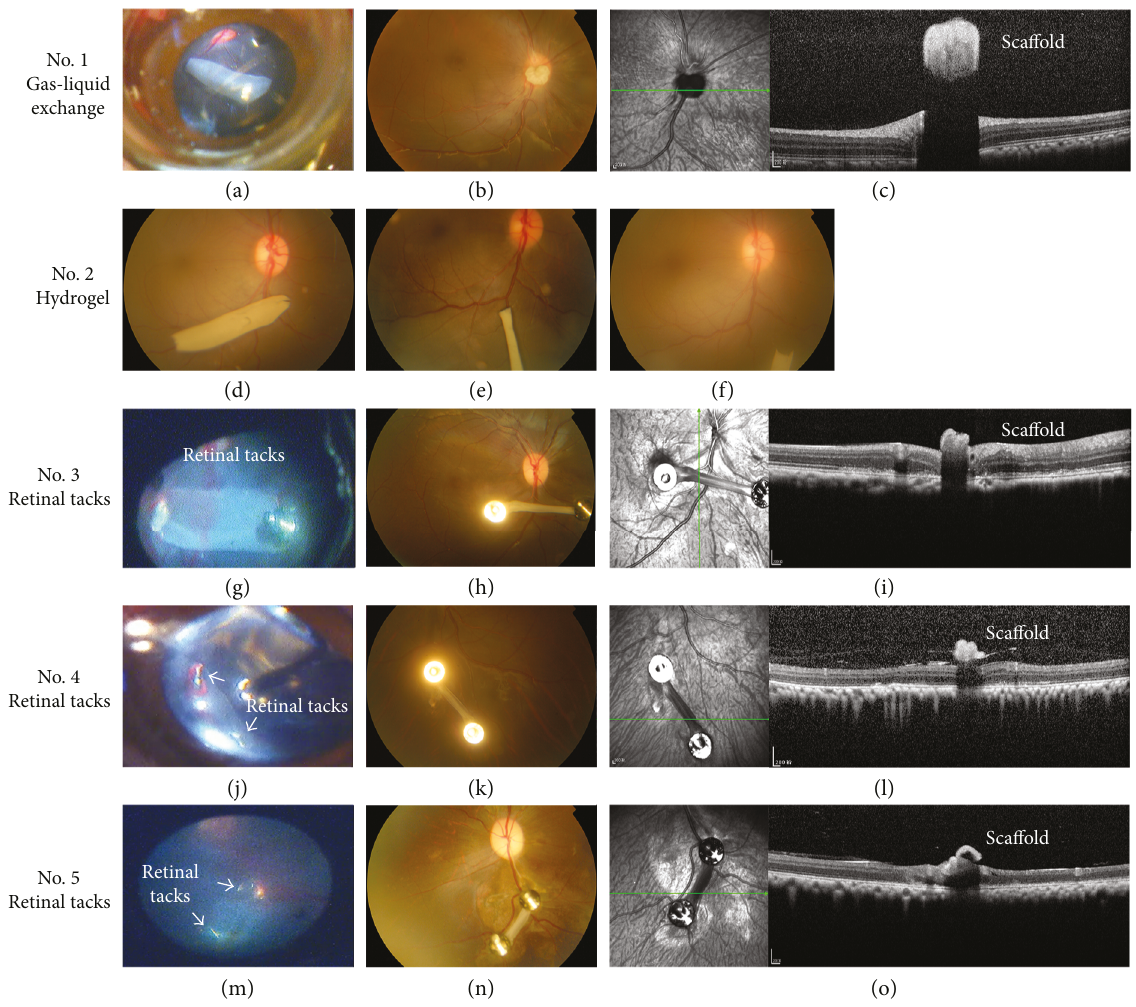
Figure 3: The fundus photograph and OCT scan of PLGA sca ff old epiretinal fi xation. (a) Photography of PLGA sca ff old fi xation after gas-liquid exchange in the surgery. (b) Fundus photography at one-month post-PLGA sca ff old fi xation after gas-liquid exchange. (c) SD-OCT photography at one month after PLGA sca ff old fi xation after gas-liquid exchange. (d) Photography of PLGA sca ff old fi xation by hydrogel in the surgery. (e) Fundus photography at one week after PLGA sca ff old fi xation by hydrogel. (f) Fundus photography at one month after PLGA sca ff old fi xation by hydrogel. (g, j, and m) Photography of PLGA sca ff old fi xation by retinal tacks in the surgery. (h, k, and n) Fundus photography at one month after PLGA sca ff old fi xation by retinal tacks. (i, l, and o) SD-OCT at one month after PLGA sca ff old fi xation by retinal tacks. The two sides of the sca ff old were degraded, and the remaining central region was curled. Table 2: Sca ff old fi xation outcomes and complications of sca ff old fi xation surgery with retinal tacks in rhesus eyes. Number Surgery Fixation Fundus hemorrhage Retinal